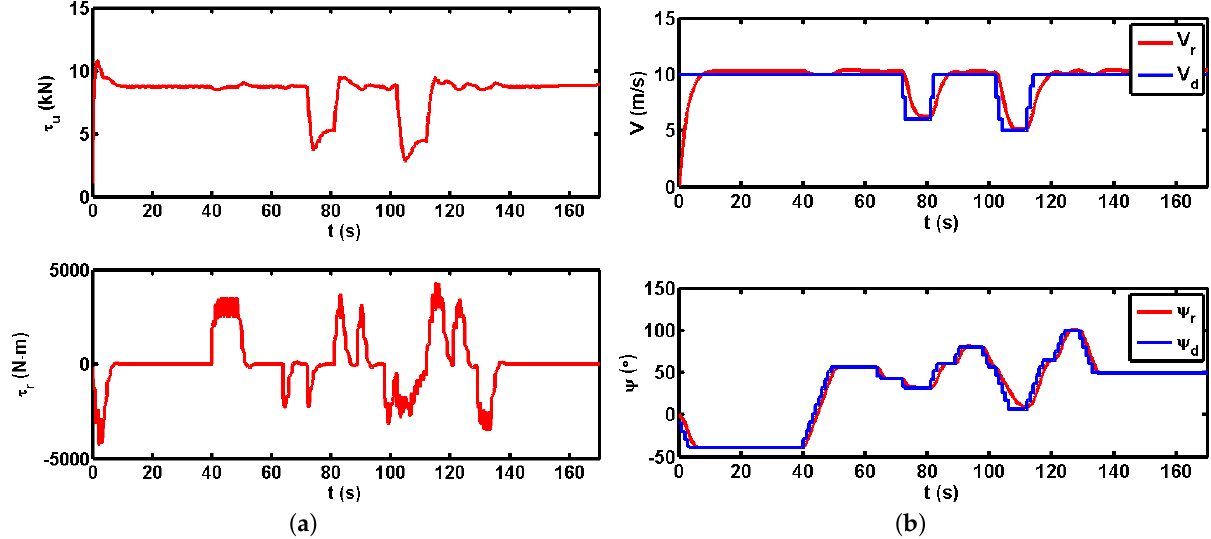
Figure 11. Input and output results for the controller. ( a ) The input of the controller; ( b ) The final control output of